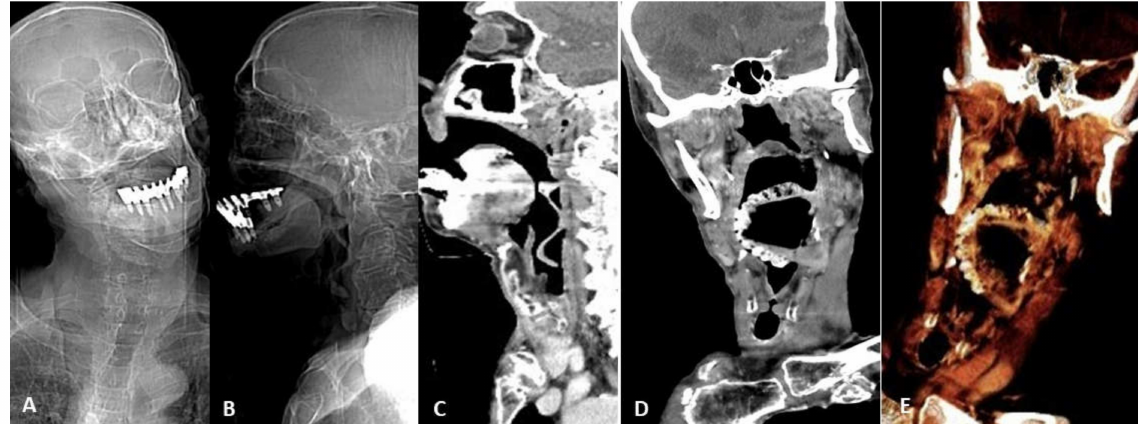
Figure 4. Device migration. Eighty-seven-year-old man affected by Alzheimer disease and asphyxiation crisis. Frontal ( A ) and lateral ( B ) head and neck CT scout views show denture migration with hypopharynx impaction. Contrast-enhanced CT sagittal ( C ) and coronal ( D ) scans better show denture relationship with the surrounding structures and demonstrate anterior epiglottis displacement with subsequent airways restriction (arrow). 3D VR image thin slab (5 mm) view ( E ) better shows device migration.